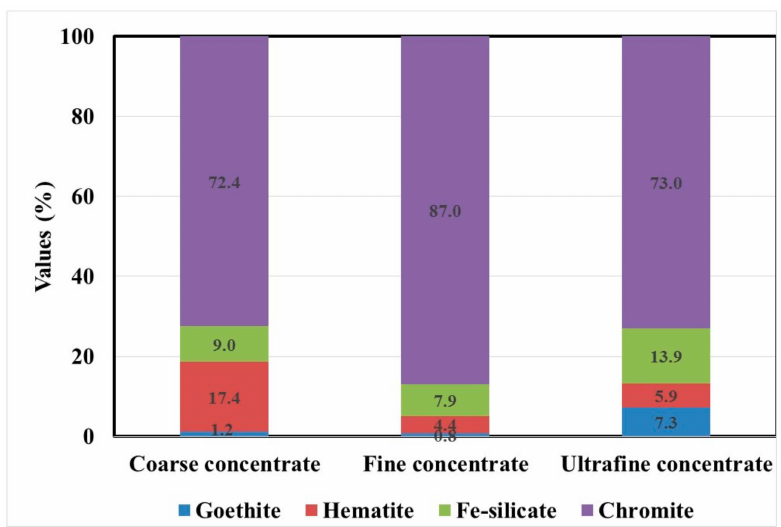
Figure 5. The iron deportment in di ff erent iron bearing mineral phases of the